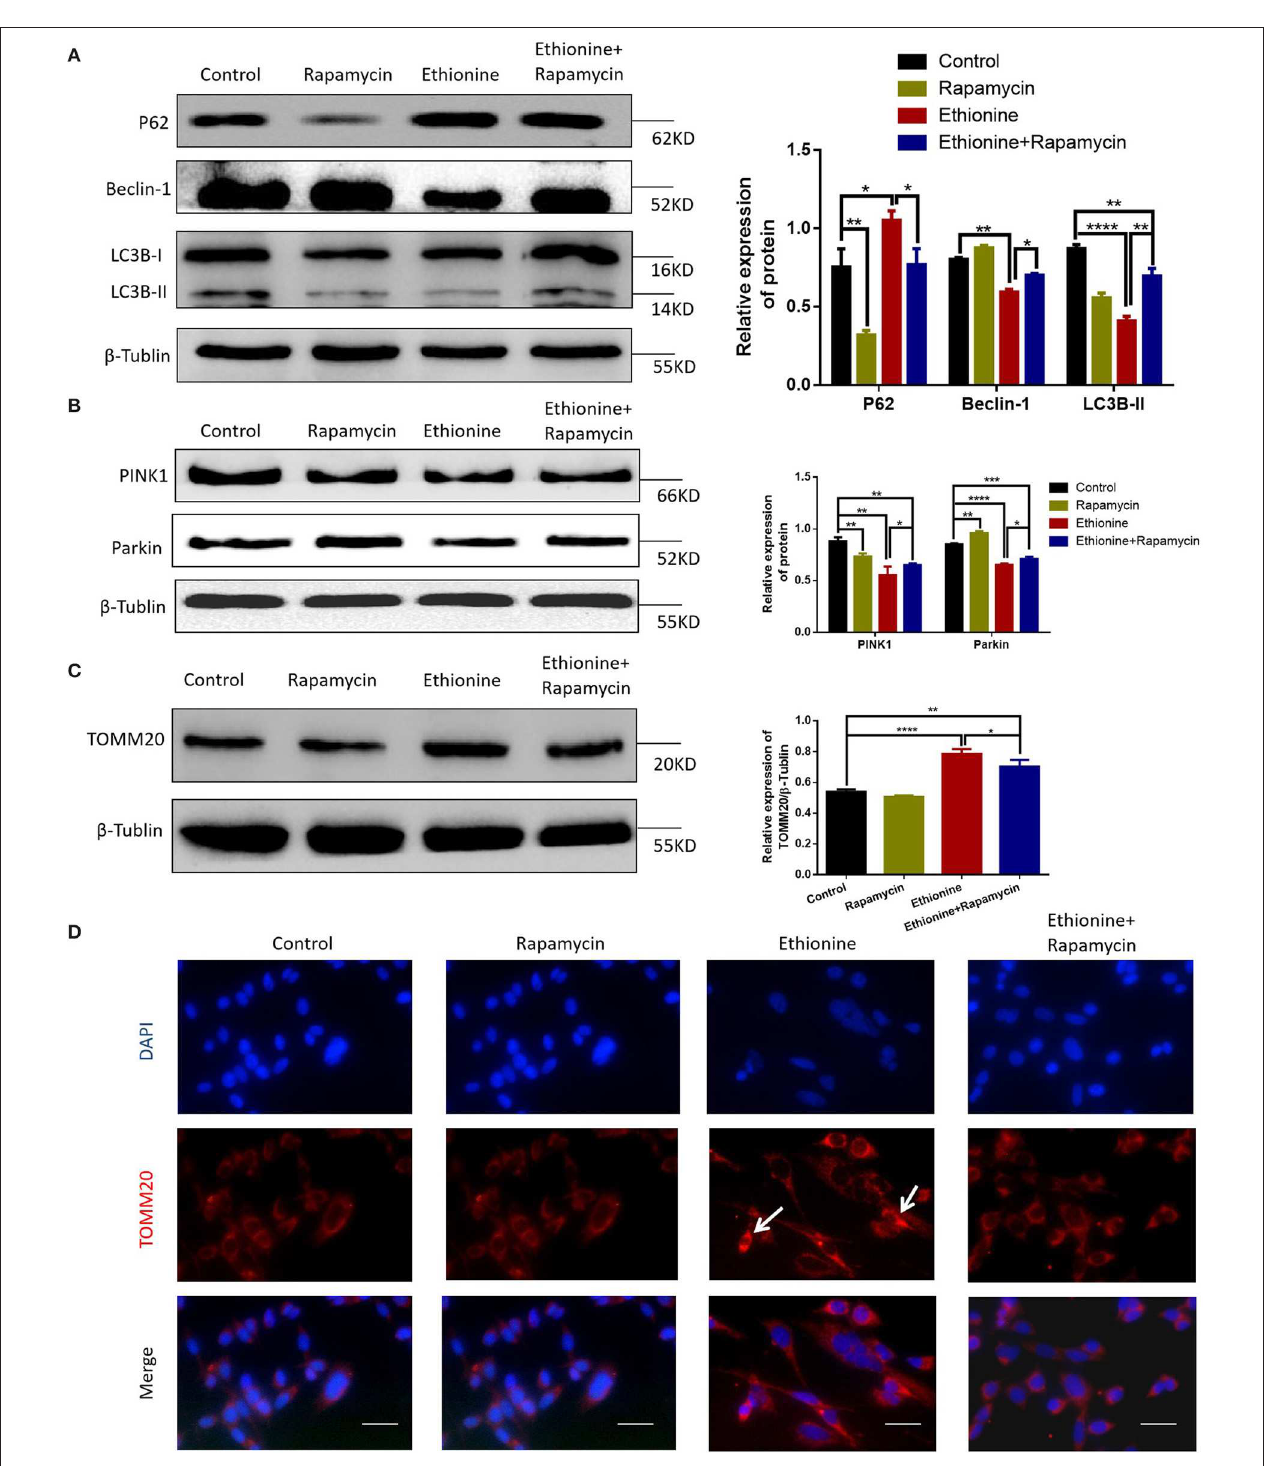
FIGURE 7 | Ethionine inhibited PINK1-Parkin-mediated mitochondrial autophagy. (A) HT-22 cells were treated with ethionine and rapamycin, autophagy related mark-LC3B, P62, Beclin-1 protein level in control and experiment groups were evaluated via Western blotting. (B) PINK1, Parkin protein levels in control and experiment groups were evaluated via Western blotting. (C) TOMM20 protein levels in control and experiment groups were evaluated via Western blotting. For all β -Tublin level was evaluated to confirm equal loading ( n = 3). One-way ANOVA followed by LSD t -test were used for difference compared with other groups, * P < 0.05, ** P < 0.01, *** P < 0.001, and **** P < 0.0001. (D) Fluorescence microscopy analysis of TOMM20 (red) staining in HT-22 cells after treatment with ethionine and rapamycin for 48h. Nuclei were also stained with DAPI, and representative single optical sections and merge images are shown. Scale bars: 500 µ m. Each experiment was carried out in